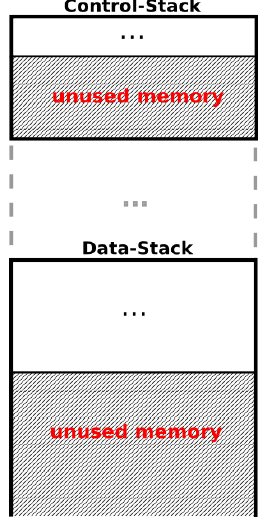
Figure 16. Schematic memory usage of control and data stack after the initialization